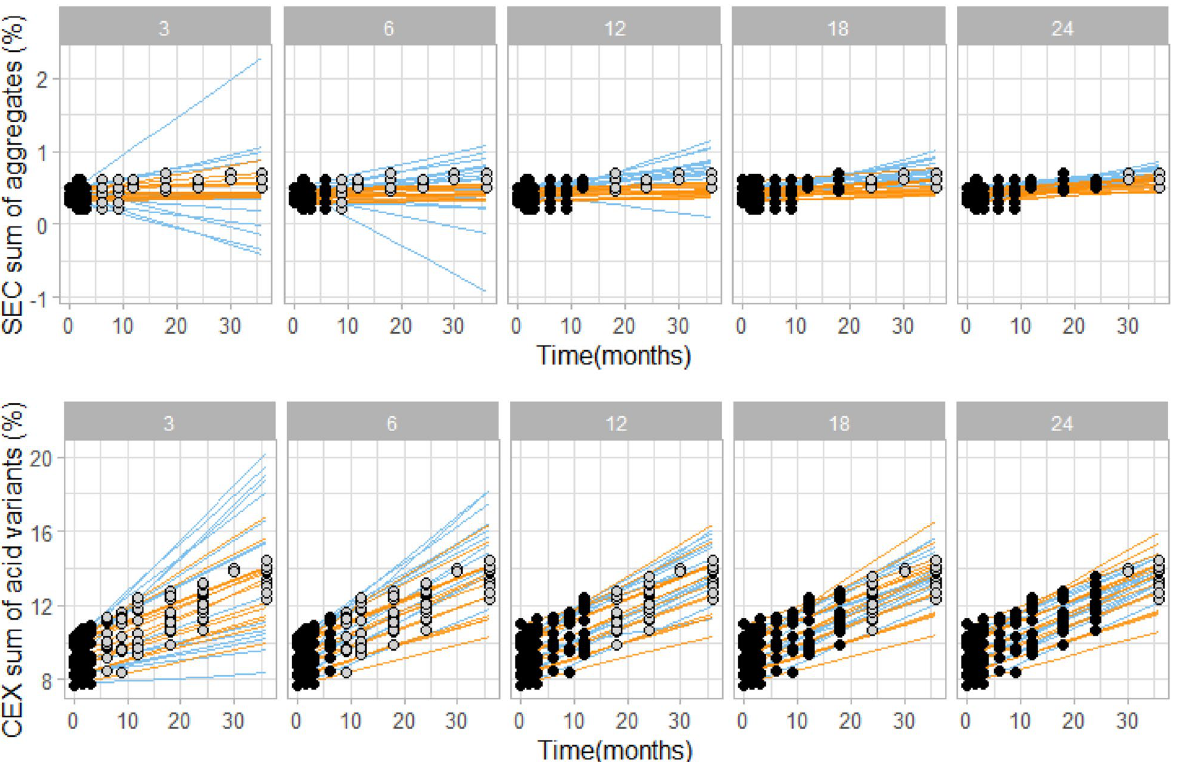
Figure 6. Comparison of kinetic modelling (orange) and linear (blue) extrapolation, showing prediction curves based on 3, 6, 12, 18 or 24 month experimental stability data (black data points). In grey, remaining measured data points at intended storage are shown for visual verification of the prediction intervals. Data shown is for 23 rituximab batches stored at 5 °C. For kinetic modelling data points from 25 and 40 °C conditions up to the respective time point were used (data points not shown for clarity